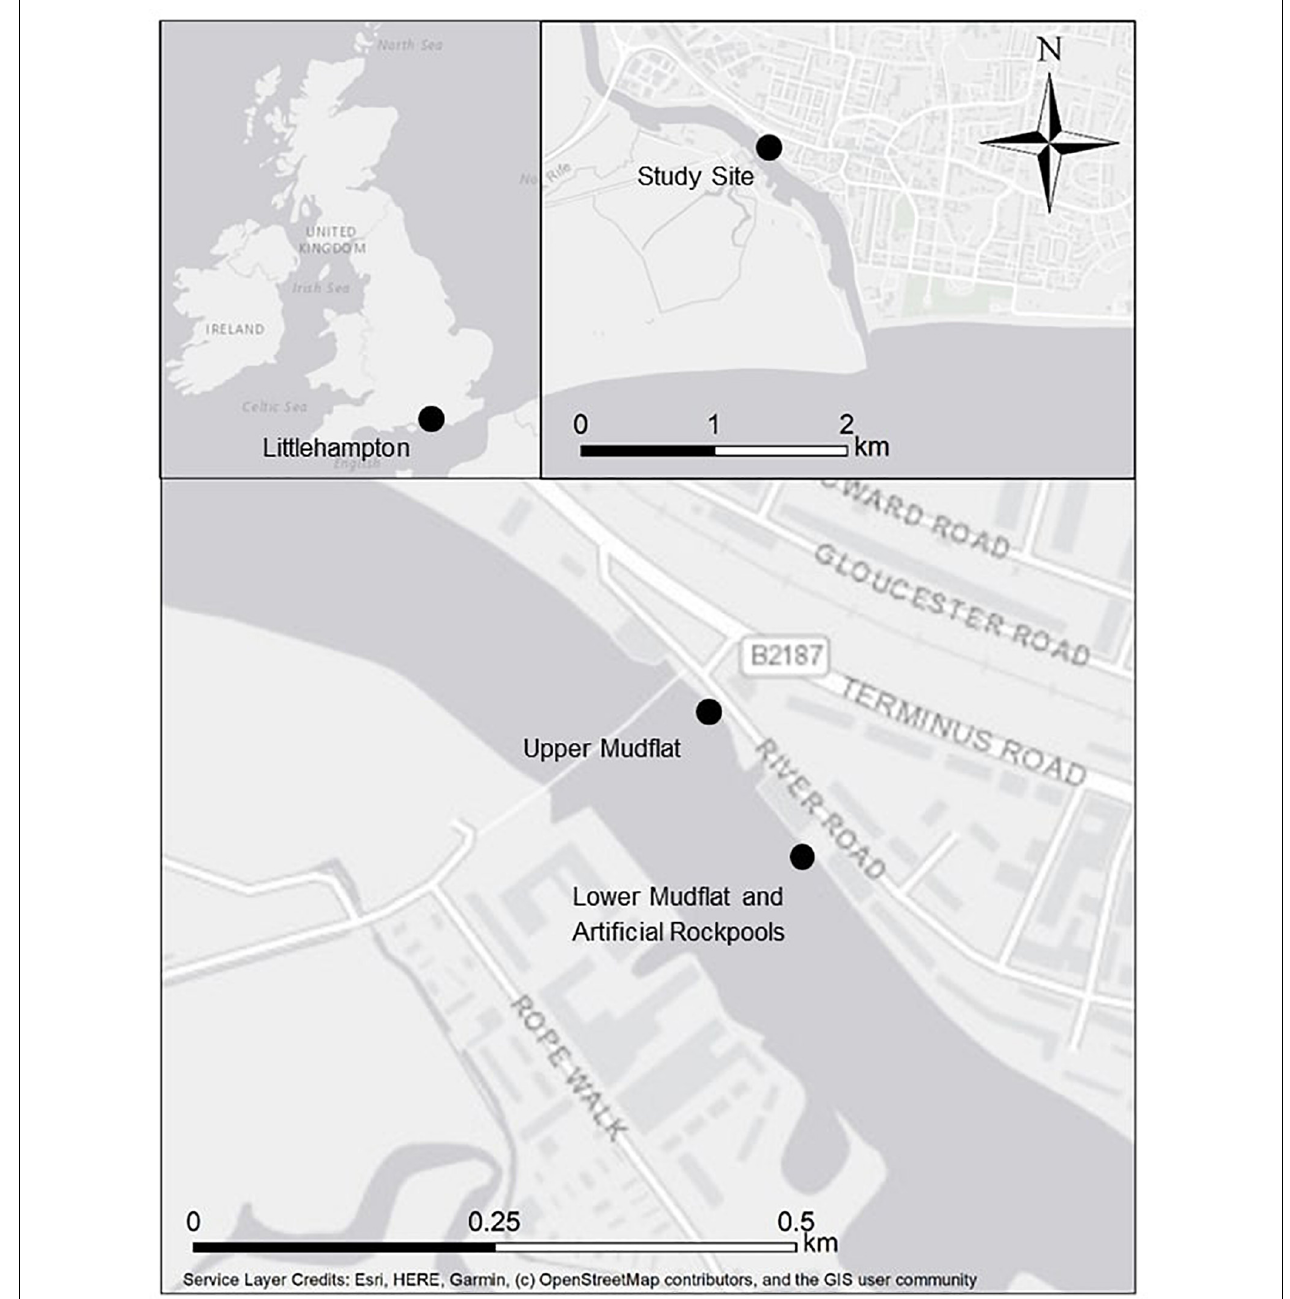
FIGURE 1 | Location of survey sites at Littlehampton Harbour on the River Arun, south coast of England.